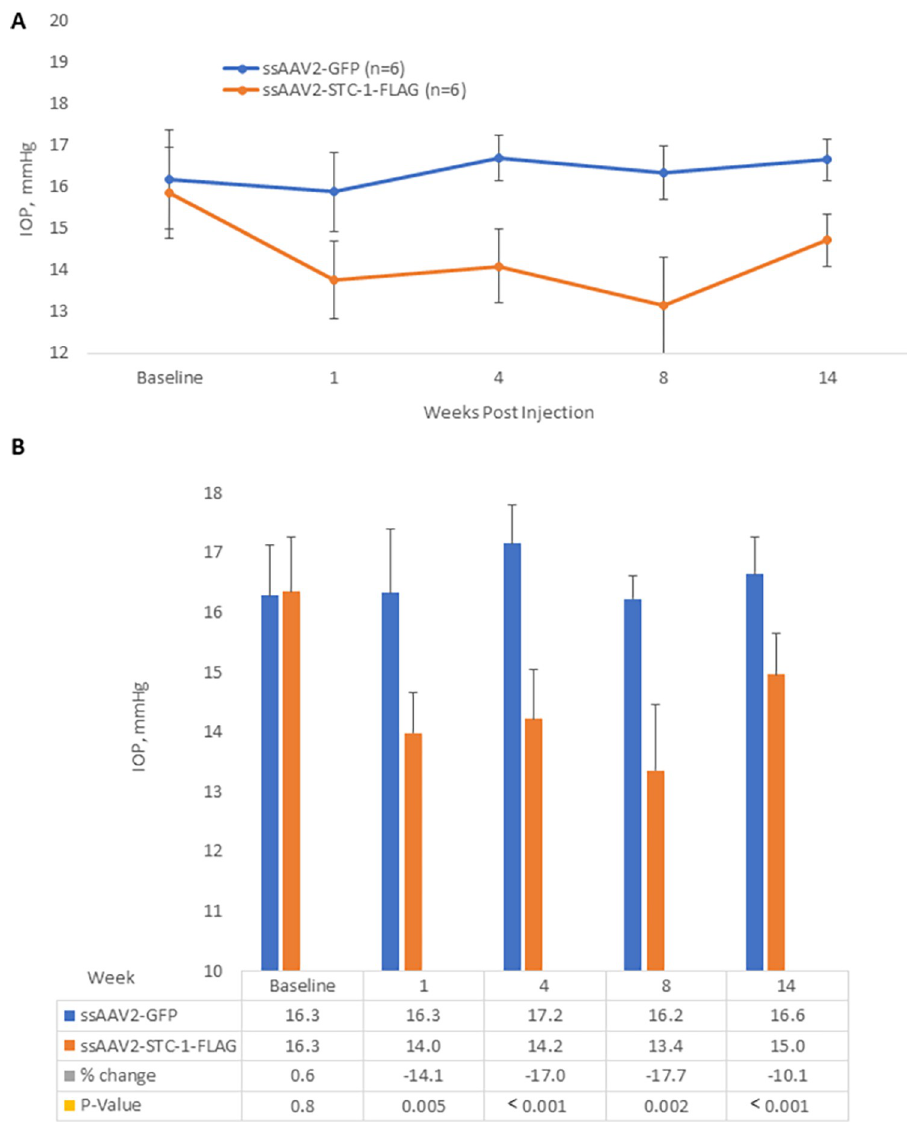
Fig 6. ssAAV2-STC-1-FLAG reduces IOP in the FP receptor knockout mouse. A) After baseline IOP measurements, ssAAV2-STC-1-FLAG (3x10 9 VGs) was injected in one eye and ssAAV2-GFP (3x10 9 VGs) was injected into the fellow eye (n = 6) of 3-month-old FP receptor knockout mice. IOP lowering was seen in mice treated with intracameral ssAAV2-STC-1-FLAG starting by week 1 post-injection and this persisted through the remainder of the experiment indicating that IOP-lowering is independent of the FP receptor. B) Data presented in a bar graph with statistical analysis performed at week 1, 4, 8, and 14 post-injection.